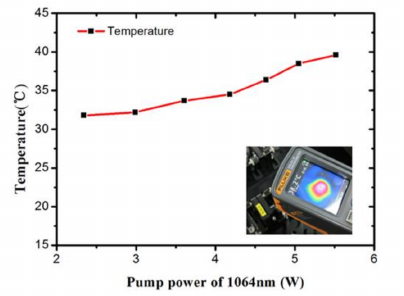
Figure 5. The surface temperature of the BGSe crystal versus the pump